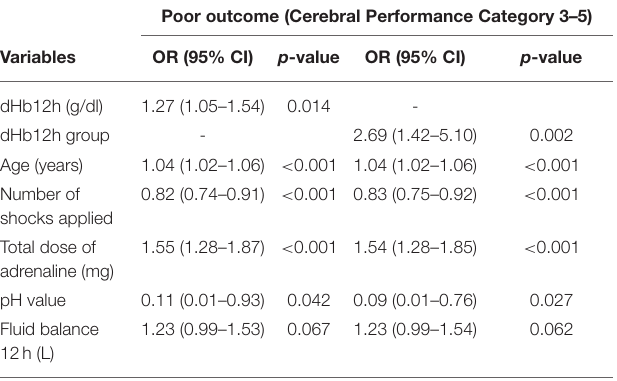
TABLE 5 | Neurologic function at day 30 according to dHb12h